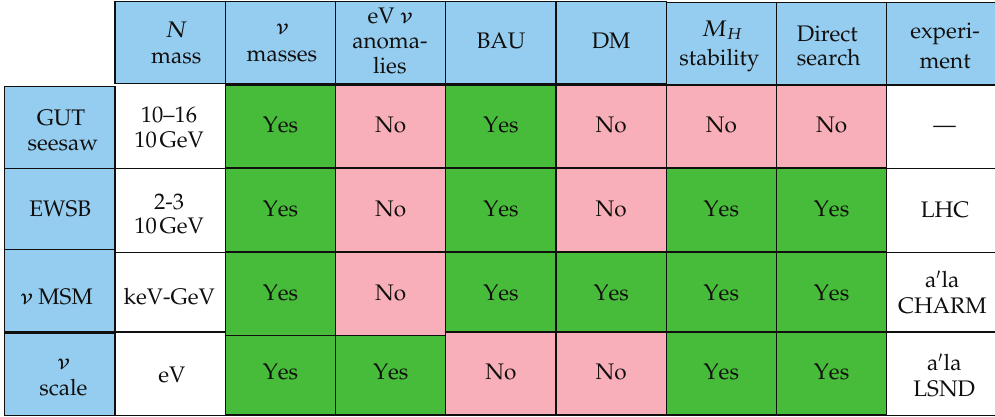
Figure 3: This table shows whether a given choice of the mass of sterile neutrinos can explain neutrino masses and oscillations, accommodate eV neutrino anomalies, lead to baryogenesis, provide a dark matter candidate, ensure the stability of the Higgs mass against radiative corrections, and is directly searched at some